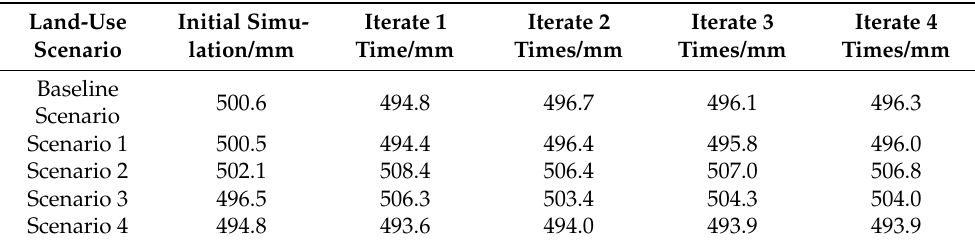
Table 8. Simulated annual evapotranspiration of multiple iterations in each